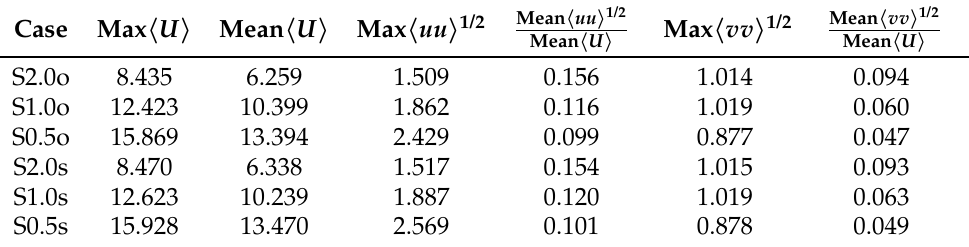
Table 3. Maxima and mean values of the streamwise velocity and fluctuations of the wall-normal and streamwise